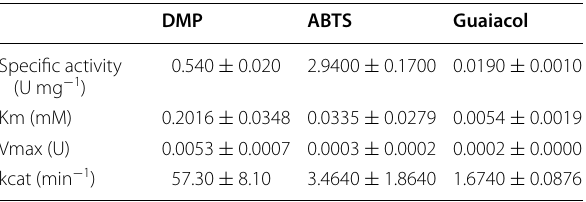
Table 1 Specific activities and kinetic constants of Sc Lac against DMP, ABTS and